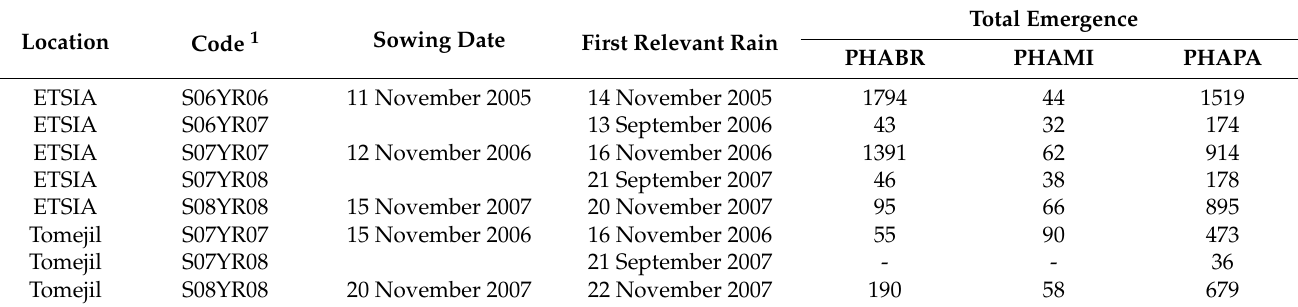
Table 1. Sowing locations and codes, sowing dates, dates of the first relevant precipitation and the total number of emergences for each Phalaris species, considering the three repetitions together. PHABR, P. brachystachys ; PHAMI, P. minor ; PHAPA, P. paradoxa